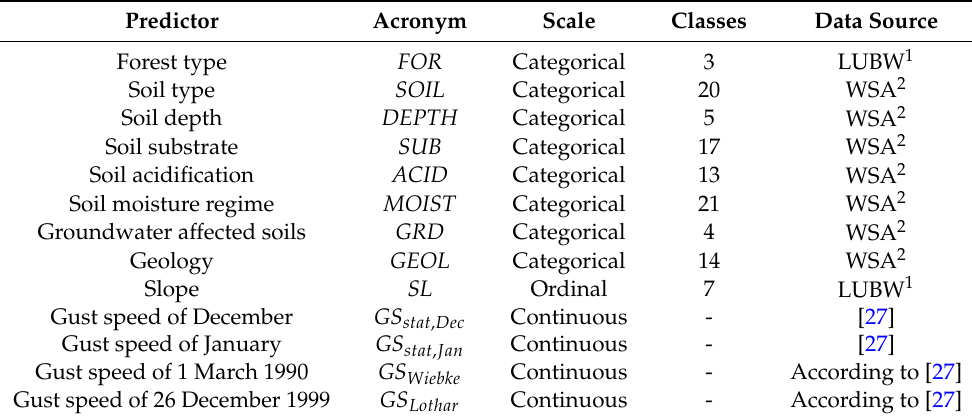
Table 1. List of predictor variables